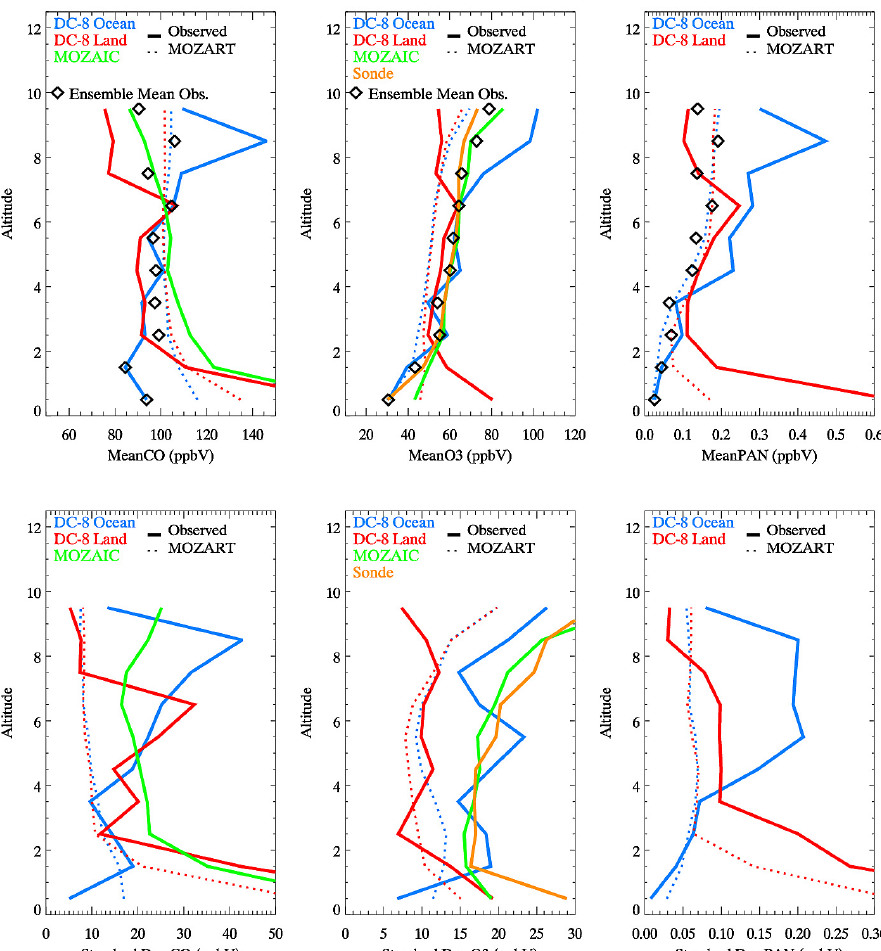
Fig. 9. Mean and standard deviation of vertical profiles for CO, O 3 and PAN from the different data sets DC8-Ocean (blue), DC-8 Land (red), MOZAIC (green) and ozonesondes (orange). Observations are shown in thick solid lines, and MOZART regional averages (AVGRe- gionTime) in dotted lines. The ensemble mean observed profile is denoted by symbols. For altitudes < 2km the ensemble mean is derived from DC-8 Ocean and ozonesonde data only. Except for MOZAIC and sonde data, the data have been filtered for fire